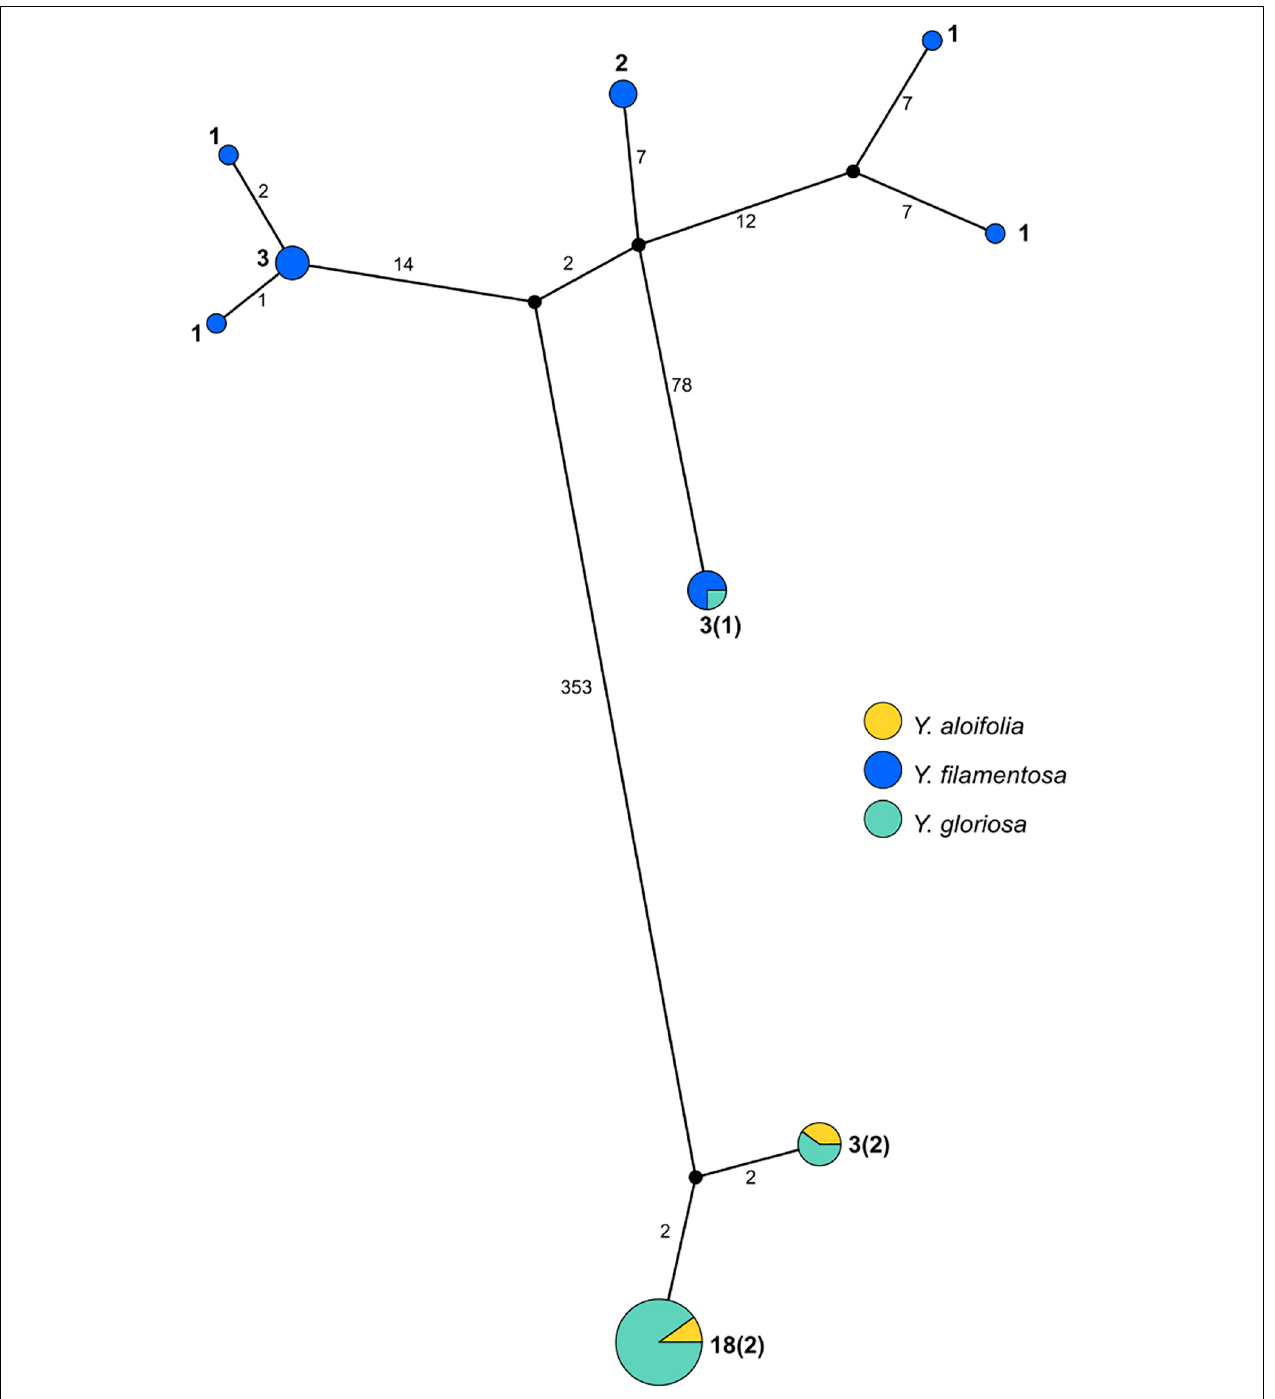
FIGURE 3 | Haplotype network estimated from the entire plastome alignment across all three species, excluding outgroup accessions. Haplotype estimated via PopArt, with number of substitutions separating haplotypes on branches and size (number of individuals) indicated in boldface numbers next to haplotypes, with majority number and, in parentheses, minority